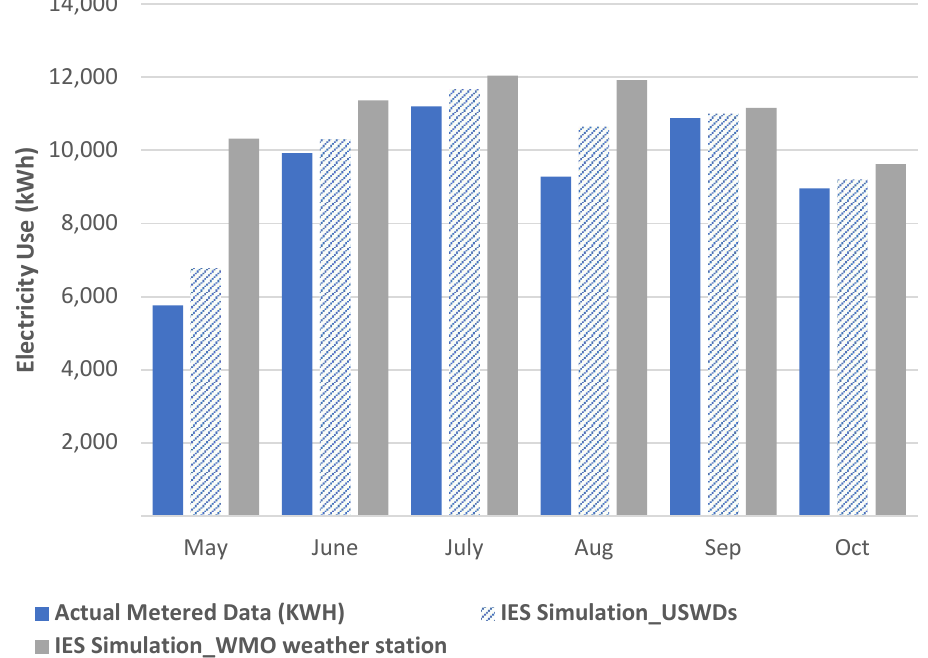
Figure 8. Actual electricity consumption v. IES-VE simulated, using USWDs and WMO data.